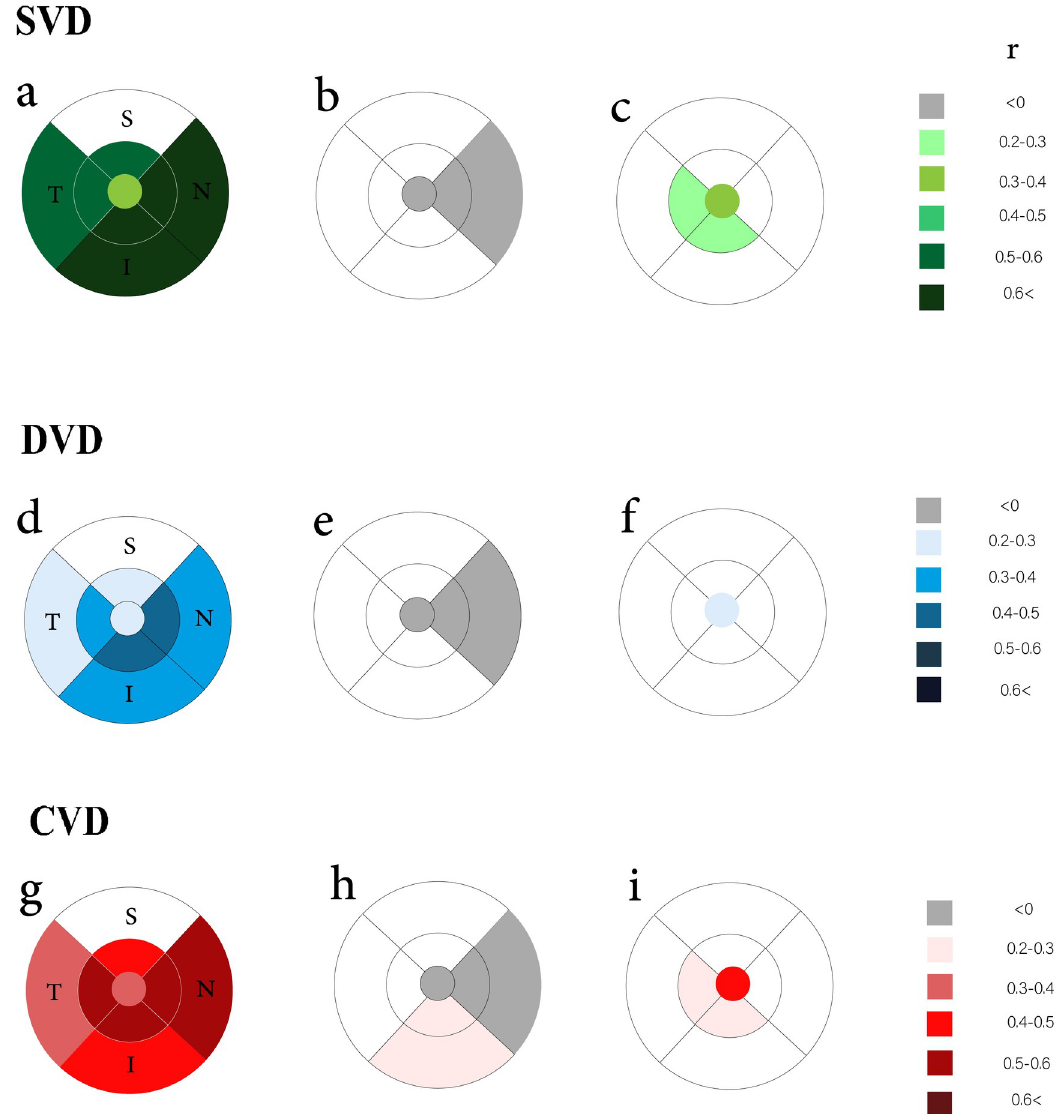
Fig 1. These diagrams show the correlation between vascular flow density and retinal thickness in normal healthy children under 18 years old. In each ETDRS zone magnitude of the significant correlation coefficient (r) is colored regarding the color bar. (a), (b) and (c) show the correlation between superficial capillary plexus vascular density (SVD) and inner, middle and outer retinal thicknesses, respectively. The correlation coefficient between deep capillary plexus vascular density (DVD) and inner, middle and outer retinal thicknesses depicted in images is shown in (d), (e) and (f), consequently. The correlation between choriocapillaris vascular density (CVD) and inner, middle and outer retinal thickness is shown in (g), (h) and (i), correspondingly. Abberivations: I: inferior; N: nasal; S: superior; T: